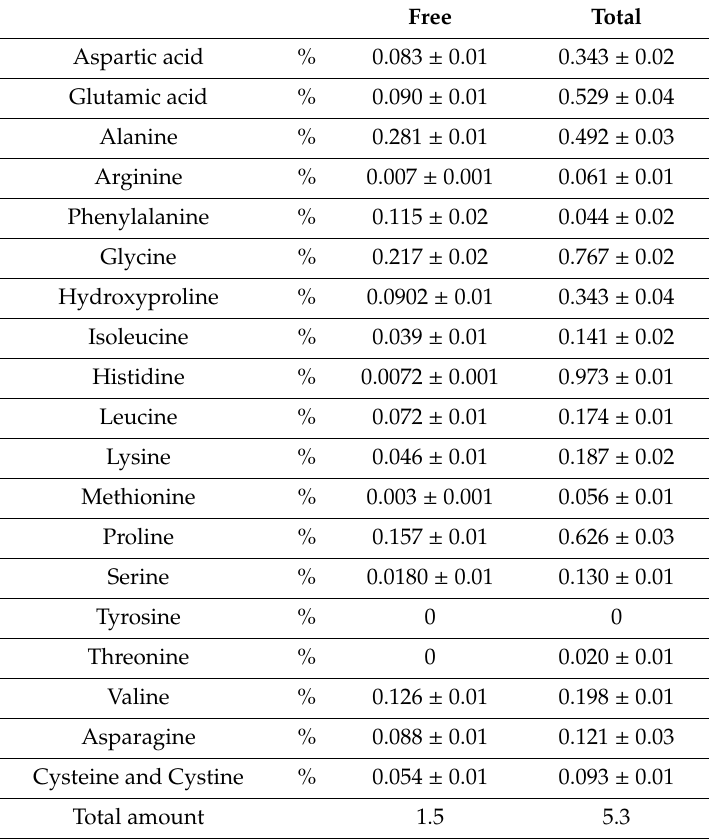
Table 7. The aminoacidic analysis in plant extract biostimulant. Values are reported as %m /